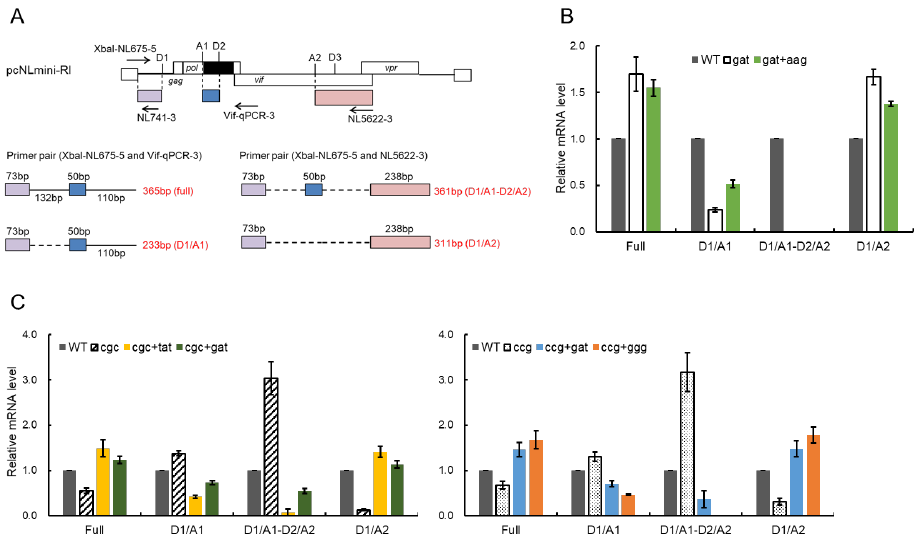
Figure 8. Effects of adaptive mutations on mRNA production. ( A ) mRNA produced from the minigenome. Splicing sites on the minigenome are presented. The primers used for the splicing pattern analysis are indicated by arrows with their names (upper part). Colored boxes show exons produced by splicing at various sites. In the lower part, splicing products analyzed using the primer sets are presented along with their lengths. Broken and solid lines show regions with and without splicing, respectively. ( B , C ) Changes in the splicing pattern of parental clones (gat, cgc, and ccg) by their adaptive mutations. Total RNA was prepared from HEK 293T cells transfected with the indicated minigenome vectors and subjected to semiquantitative RT-PCR using the primer pairs shown in ( A ). The signal intensities of semiquantitative RT-PCR products were quantitated from three independent experiments. The intensities of the indicated mRNAs in each sample were normalized to those of all viral mRNAs (D1) and gapdh mRNA. The normalized mRNA intensities in each sample relative to those of WT are